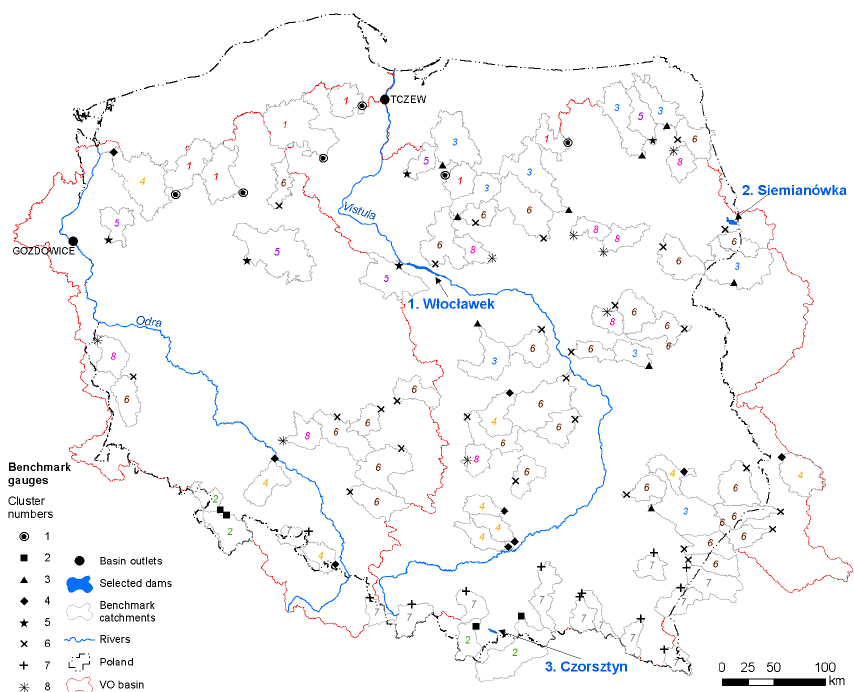
Figure 1. Division of benchmark catchments into 8 clusters and location of three studied dam reservoirs (modified after Piniewski et al.,